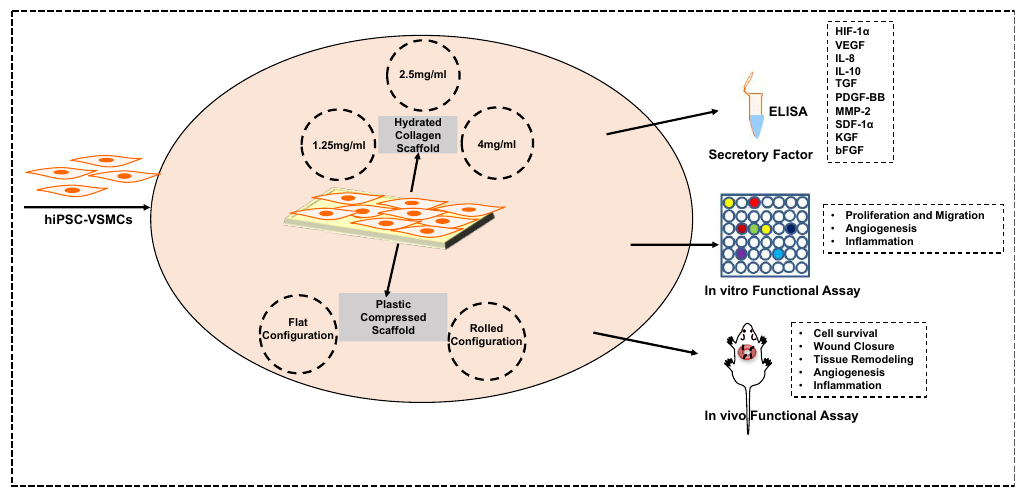
Scheme 1. Scheme of the experimental strategy. Human induced pluripotent stem cell-derived vascular smooth muscle cells and their secretory profile in response to collagen sca ff olds of varying density were characterized. In vitro functional assays of conditioned medium and in vivo testing of the cells in a splinted back wound model in nude mice were performed.